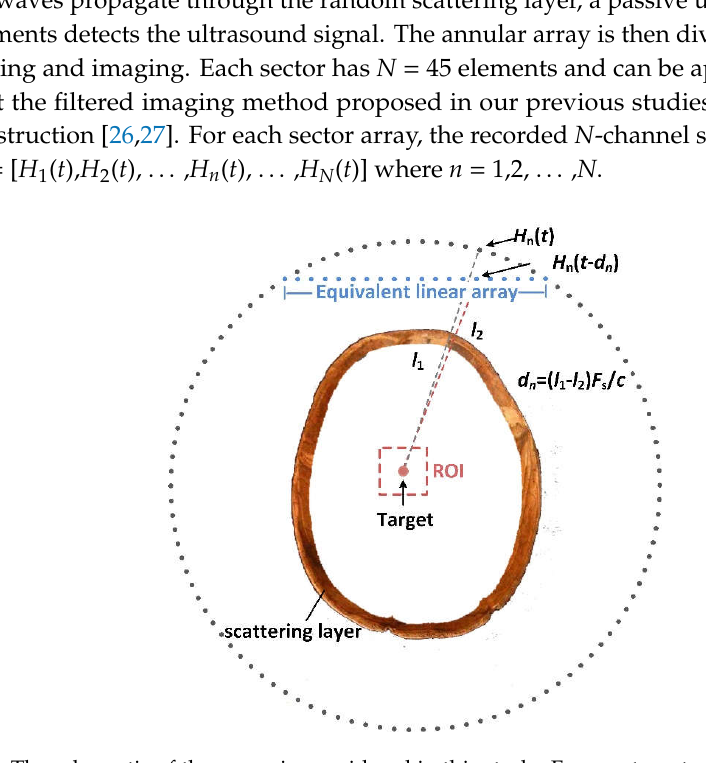
Figure 1. The schematic of the scenario considered in this study. For any target placed in the region of interest (ROI) within a scattering layer, its propagation distances to the n th transducers of a sector array, and the equivalent linear array are l 1 and l 2 , respectively. The corresponding delay is then given by d n = ( l / c , where c is the sound speed and F s is the sampling − l 1 2 ) F s